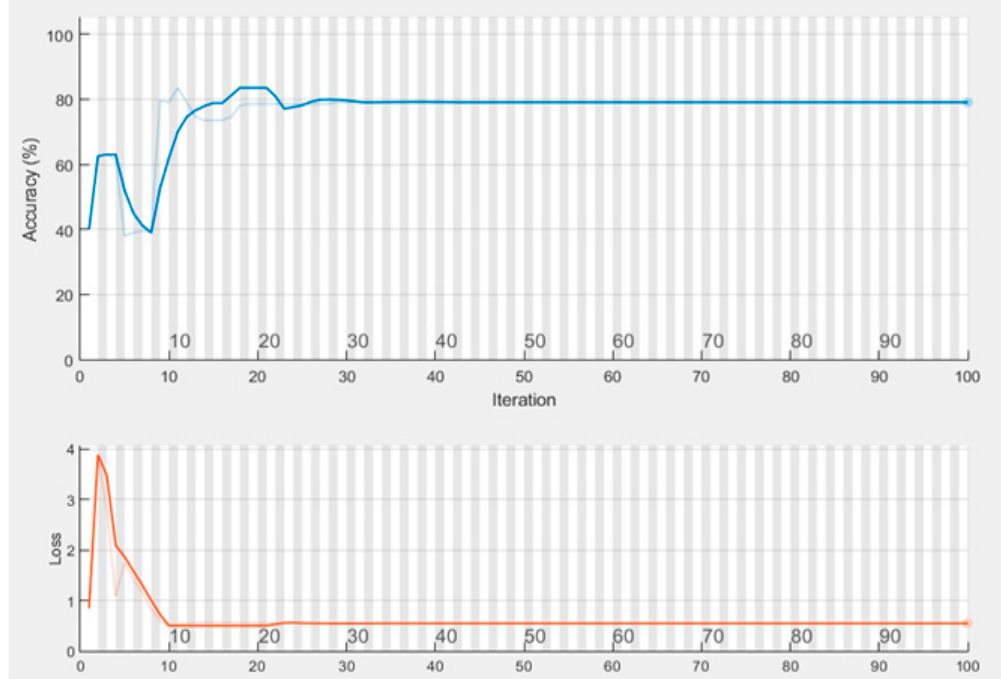
Figure 4. Training progress of the GRU-RNN for the HDD dataset.